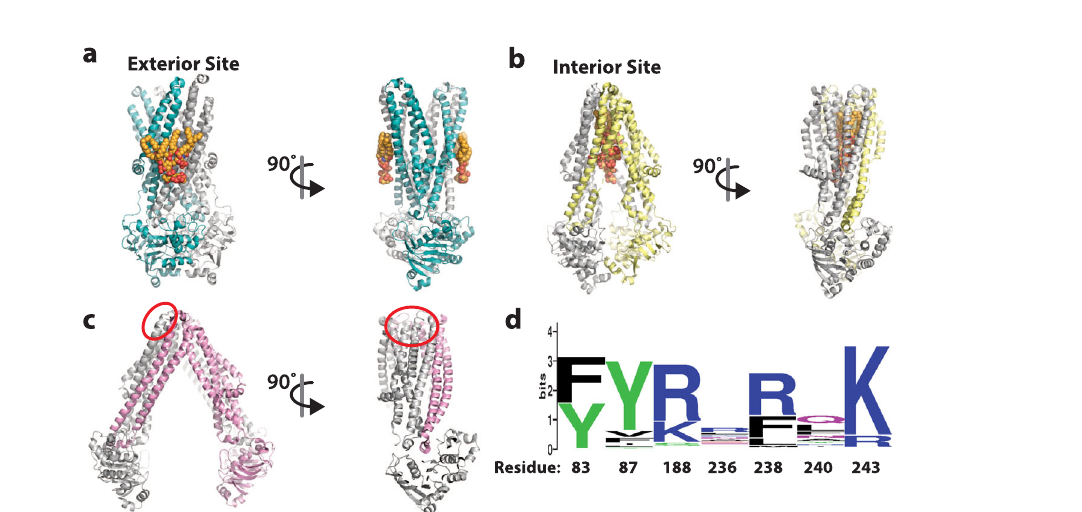
Fig. 4 | Structure of vanadate-trapped MsbA reveals a distinct, exterior KDL bindingsite.a Cryo-EMreconstruction (3.6Å)of MsbA(ADP·VO 4 ) in complex with KDL.The density forKDL is shownin yellow, and MsbA subunits areshown in pink andblue. b Coulombicelectrostaticpotential(scalebar − 10to+10ascomputedby ChimeraX 62 )iscoloredredandbluefornegativeandpositivecharges,respectively. KDL and interacting residues are shown in ball and stick representation. c MsbA